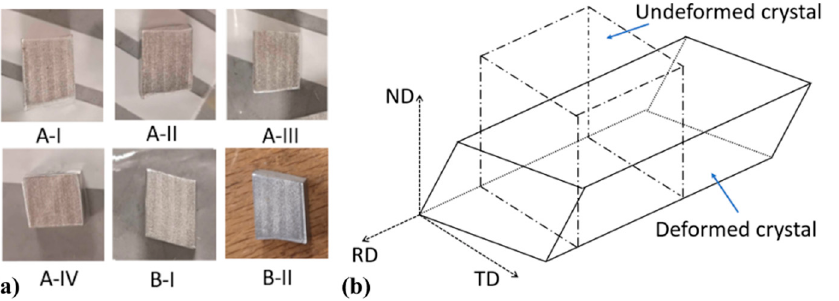
Figure 3. ( a ) Images for the deformed aluminum samples viewing from ND. ( b ) The ideal resulting crystal change of cubic sample under frictionless PSC [31] (Reprinted with permission from ref. [31]. Copyright 2021 Elsevier).